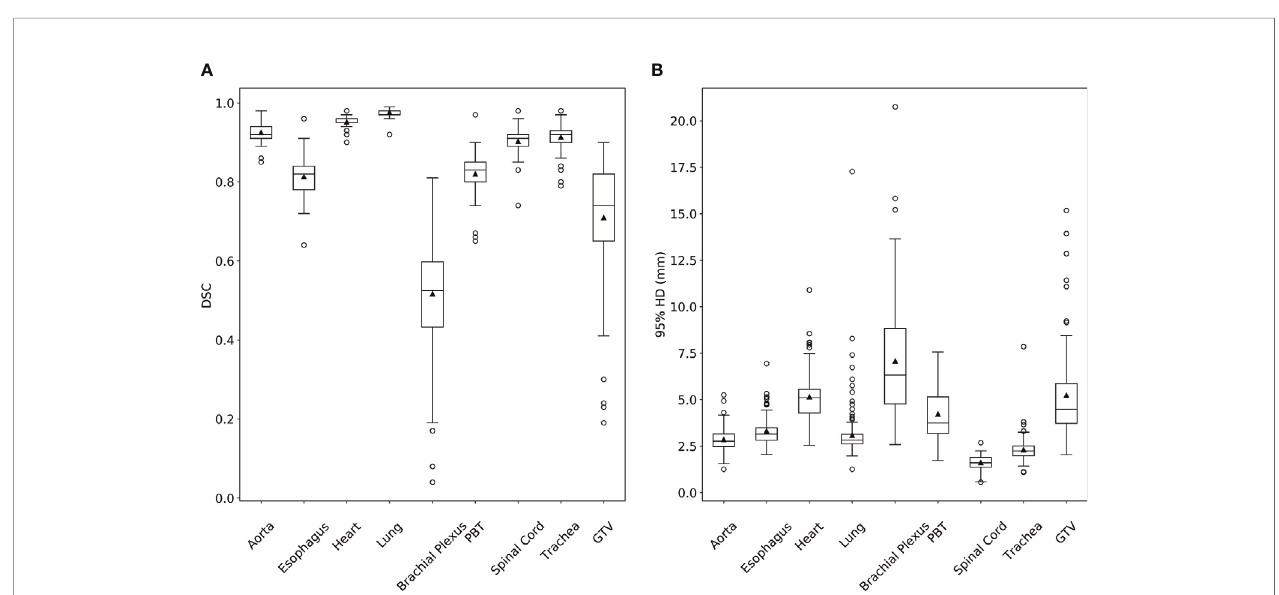
FIGURE 1 | Dice Similarity Coef fi cient (DSC, A ) and 95% Hausdorff distance (HD, B ) box plots from comparing deep learning-based auto-segmented contours to clinical contours for lung stereotactic ablative radiotherapy planning structures. (PBT, proximal bronchial tree; GTV, gross tumor